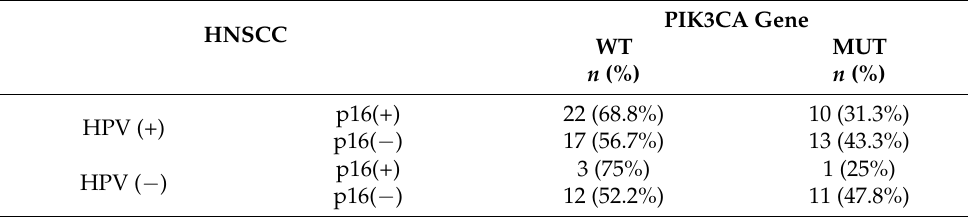
Table 2. Frequency of PIK3CA mutations in HNSCC with and without HPV DNA and p16 INK4a overexpression ( n = 89; p16 missing data n = 6).